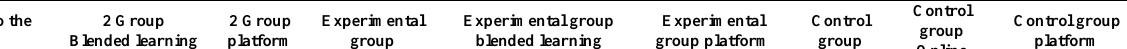
Table 2. Differences in learning through formats of the experimental group and the control